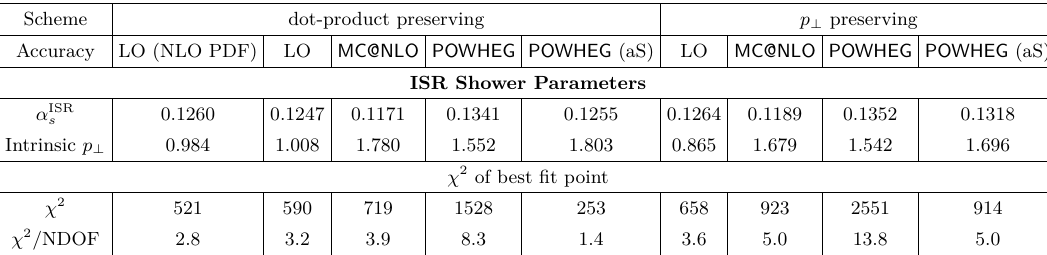
Table 1 . Tuned parameters and χ 2 for Drell-Yan Z -boson production events at 7 TeV.